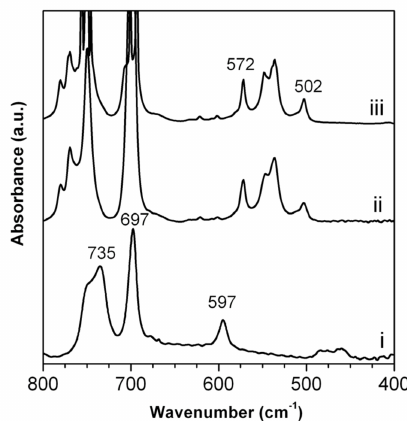
Figure 7. FTIR spectra of liquid benzyl alcohol (curve i) and sPS 0.8 / r-GO 0.2 aerogel (P = 90%) before (curve ii) and after (curve iii) immersion for 3 days in a 100 ppm benzyl alcohol aqueous solution.